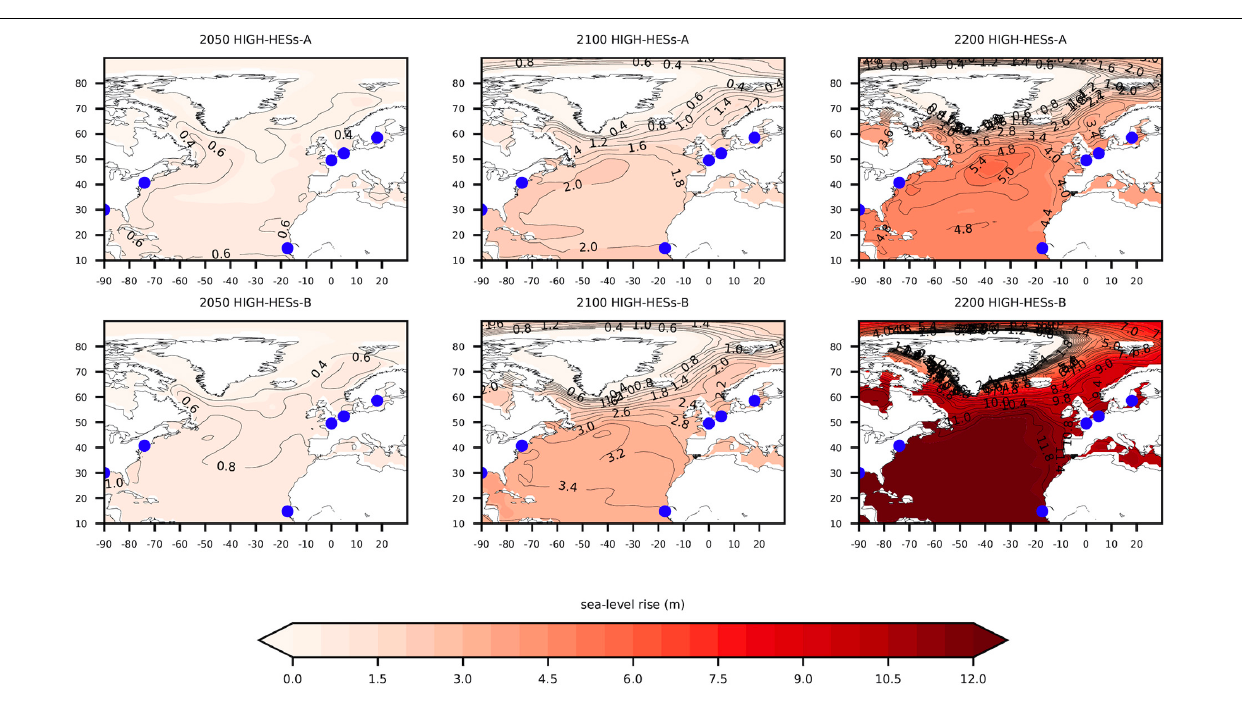
FIGURE 5 | The same as Figure 4 , but in the south-eastern